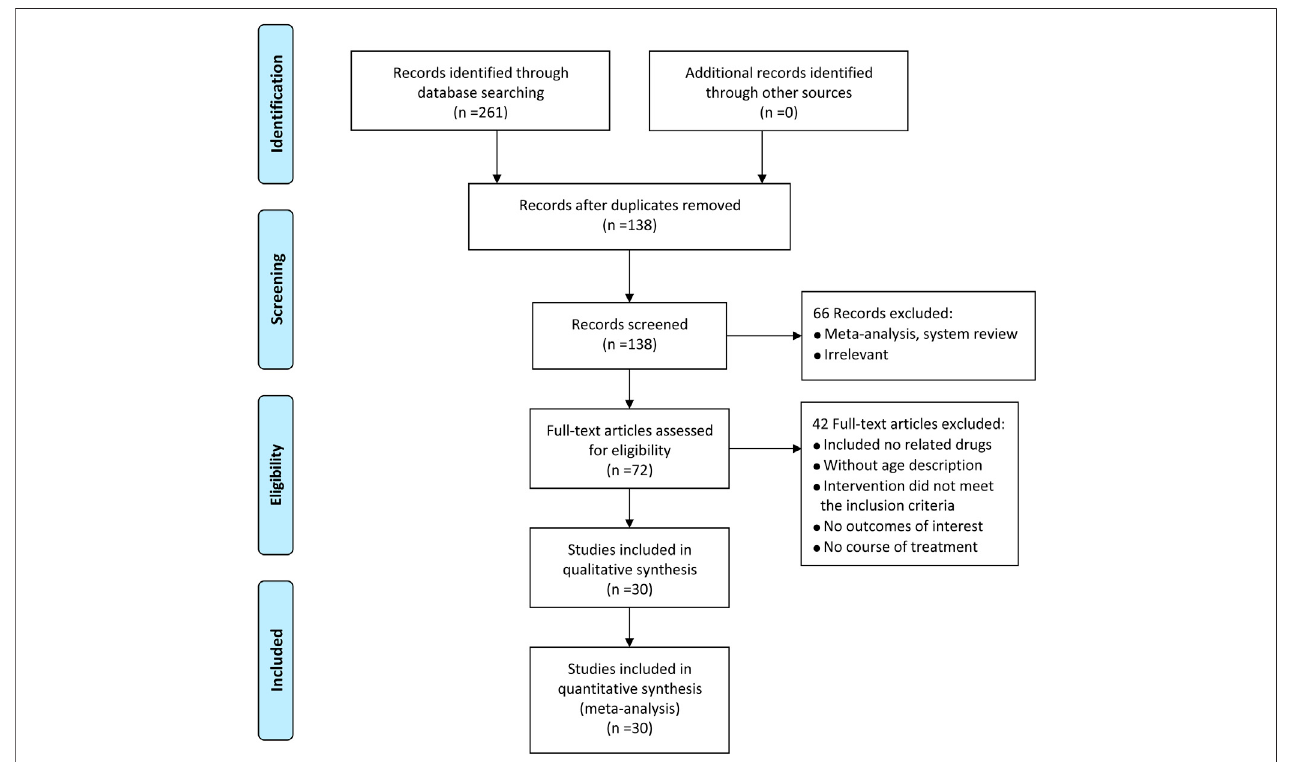
FIGURE 2 | PRISMA fl ow diagram for eligible